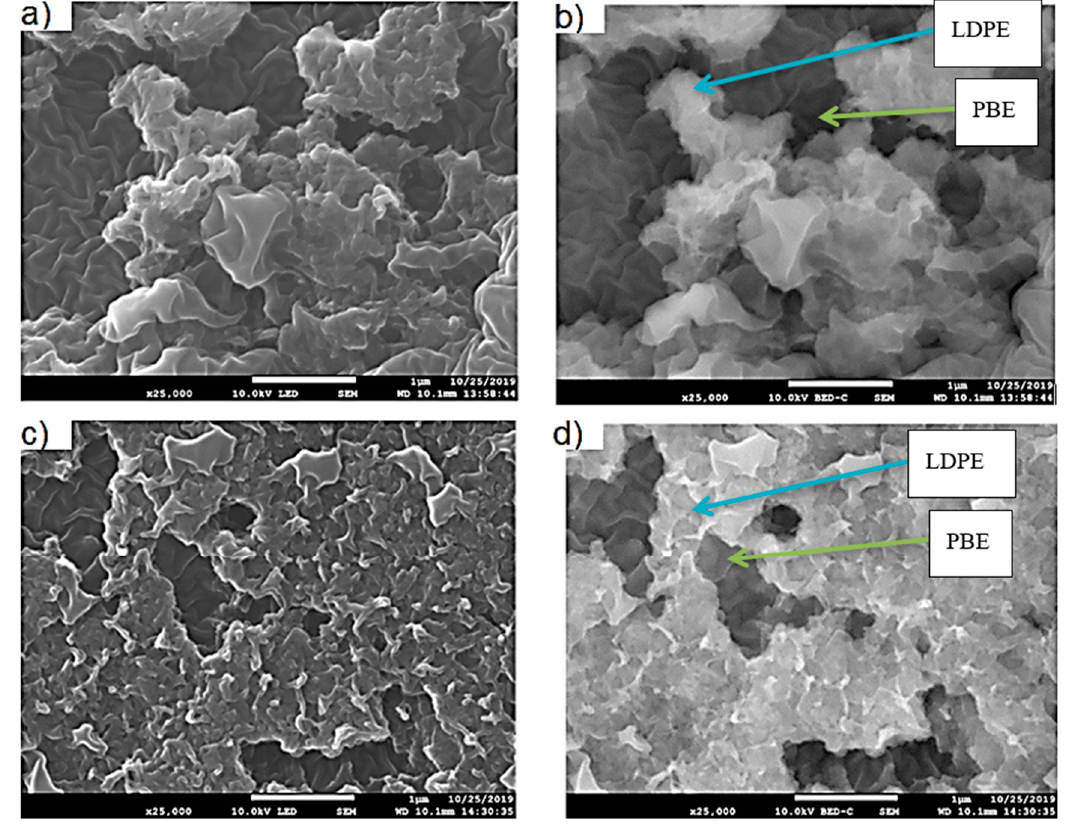
Figure 9. SEM images of the 40 ( LDPE KB 10 CNT 5 ) /60PBE ( a , b ) and 60 ( LDPE KB 10 CNT 5 ) /40PBE ( c , d ) Figure 9. SEM images of the (cid:2781)(cid:2777)((cid:1786)(cid:1778)(cid:1790)(cid:1779) (cid:1785)(cid:1776) (cid:2778)(cid:2777) (cid:1777)(cid:1788)(cid:1794) (cid:2782) )/(cid:2783)(cid:2777)(cid:1790)(cid:1776)(cid:1779) ( a and b ) and (cid:2783)(cid:2777)((cid:1786)(cid:1778)(cid:1790)(cid:1779) (cid:1785)(cid:1776) (cid:2778)(cid:2777) (cid:1777)(cid:1788)(cid:1794) (cid:2782) )/(cid:2781)(cid:2777)(cid:1790)(cid:1776)(cid:1779) in the transverse directions. ( a , c ) are in normal LED mode and ( b , d ) are in backscattered mode. LDPE ( c and d ) in the transverse directions. ( a ) and ( c ) are in normal LED mode and ( b ) and ( d ) are in is whiter and the PBE is backscattered mode. LDPE is whiter and the PBE is darker.